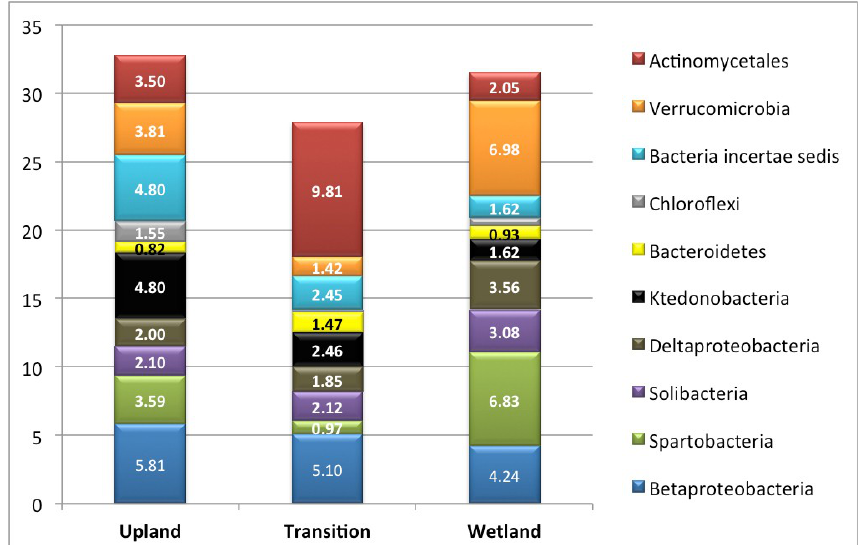
Figure 3. A representation of significant taxa at lower relative abundance